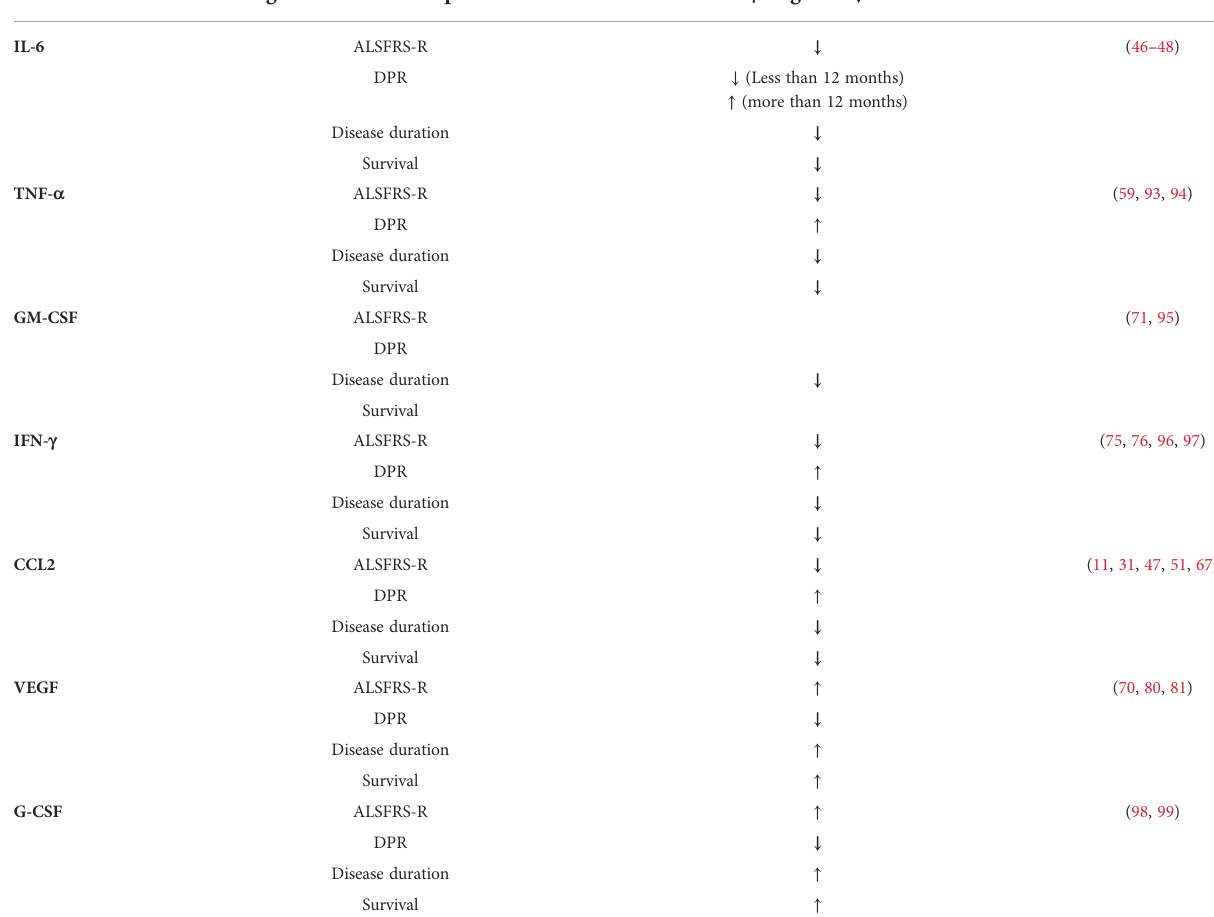
TABLE 2 Association of cerebrospinal fl uid Cytokines and prognostic evaluation parameters in ALS patients ALSFRS-R, ALS functional rating scale- revised; CCL, C-C motif chemokine ligand; DPR, disease progression rate; G-CSF, Granulocyte colony stimulating factor, GM-CSF, Granulocyte-macrophage colony stimulating factor; IL=Interleukin; IFN- g =Interferon gamma; TNF=Tumor necrosis factor; VEGF=Vascular endothelial growth factor.